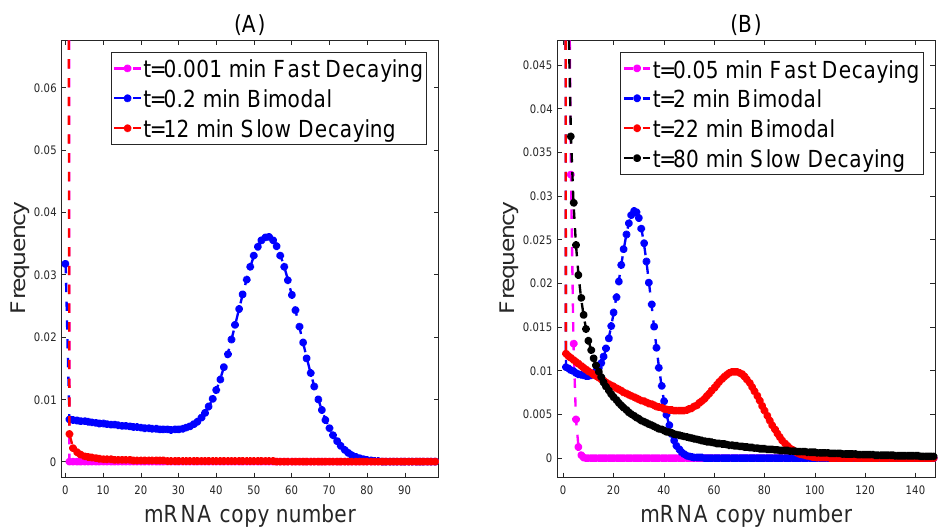
Figure 2. Cross-talking pathways generate intermediate biomodal dynamical distribution with ( A ) δ = 1.22 h − 1 , v m = 400 h − 1 , γ = 90 h − 1 , q 1 = 0.025, q 2 = 0.975, λ 1 = 0.03 h − 1 , λ 2 = 300 h − 1 and ( B ) δ = 0.14 h − 1 , v m = 45 h − 1 , γ = 1.9 h − 1 , q 1 = 0.35, q 2 = 0.65, λ 1 = 0.03 h − 1 , λ 2 = 15 h − 1